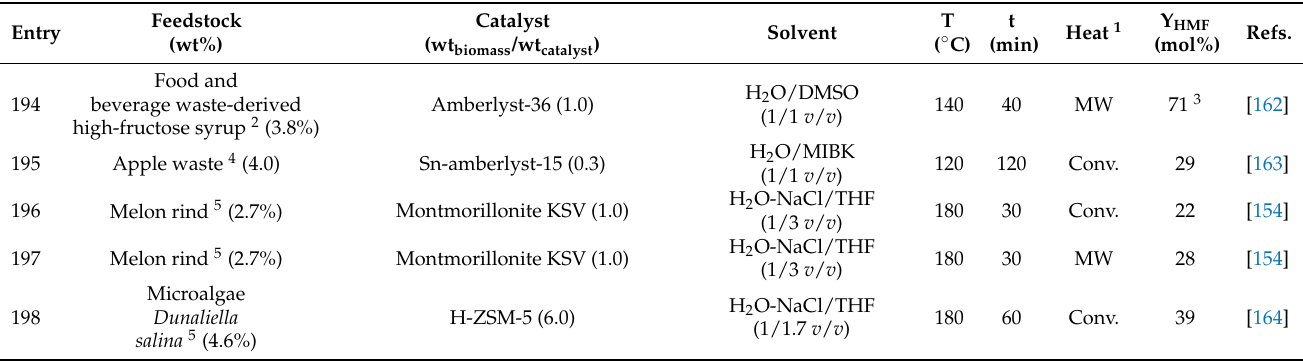
Table 10. HMF production from raw pretreated biomasses in biphasic and/or multiple-solvent systems with heterogeneous